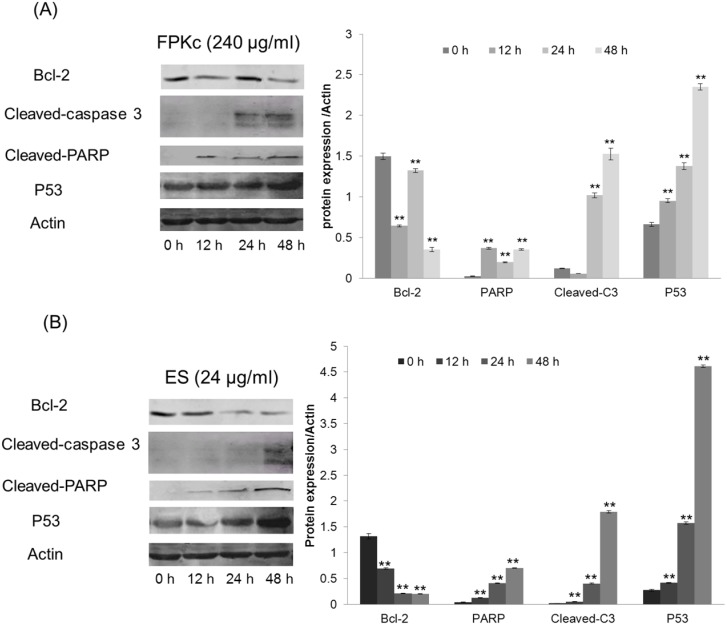
Effects of FPKc (A) and ES (B) on the expression of proteins associated with cell cycle and apoptosis in SW-480 cells.SW-480 cells were treated with 240 µg/ml FPKc and 24 µg/ml ES for 12, 24, 48 h. Western blot analysis was performed in triplicate per experimental point; Actin was used as reference control.